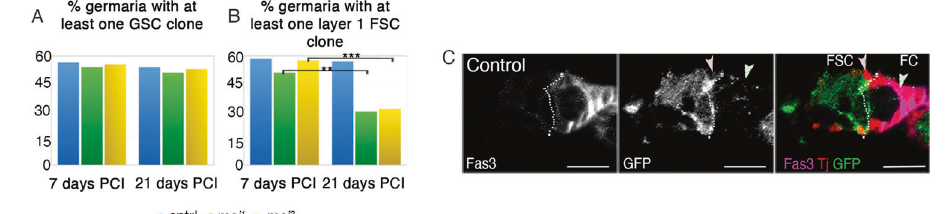
Fig. 3 Msi is required for FSC maintenance, but not GSC maintenance. A The percentage of germaria containing at least on negatively marked control (blue), msi 1 (green) or msi 2 (yellow) GSC clone generated by Flp-FRT mediated recombination at 7 days PCI (56.7%, N = 97; 54.16%, N = 96 and 55.67%, N = 97 respectively) and 21 days PCI (54.16%, N = 96; 50.98%, N = 102 and 53%, N = 100 respectively). No signi fi cant differences were observed between genotypes as measured by Fisher ’ s exact test. B The percentage of germaria containing at least on negatively marked control (blue), msi 1 (green) or msi 2 (yellow) layer 1 FSC clone generated by Flp-FRT mediated recombination 7 and 21 days PCI. A signi fi cant reduction in the frequency of msi 1 (29.41%, N = 102; Fisher ’ s exact test p = 0.0023) and msi 2 (31%, N = 100; Fisher ’ s exact test, p = 0.0002) mutant FSC clones at 21 days PCI was observed. Ovarioles were acquired and imaged randomly from a minimum of 18 heat shocked fl ies of each genotype. C Single-plane confocal micrographs showing Traf fi c Jam (Tj, red) positive, GFP-negative clones generated by Flp-FRT. A FSC clone (pink arrowhead) and FC clone (pale green arrowhead)) are depicted. Scale bars, 10 µm. Dotted line represents the Fas3 expression